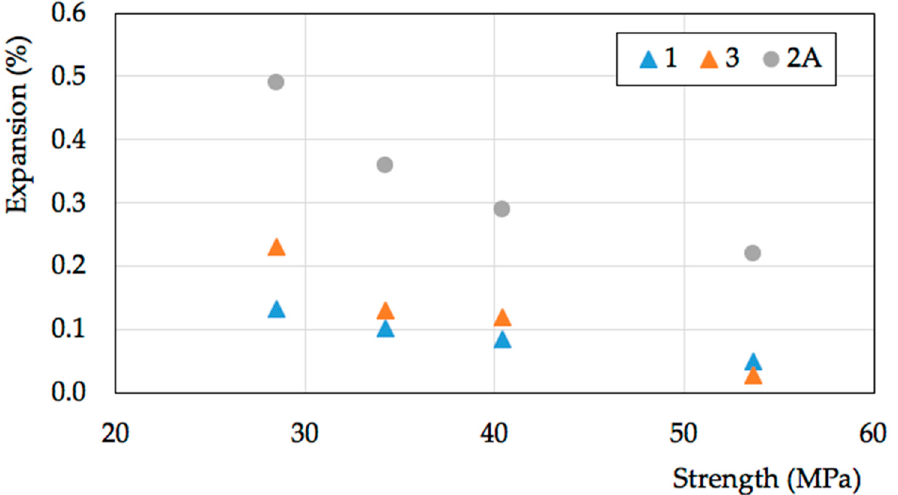
Figure 11. Expansion vs. strength for 1, 2A, and 3 samples.